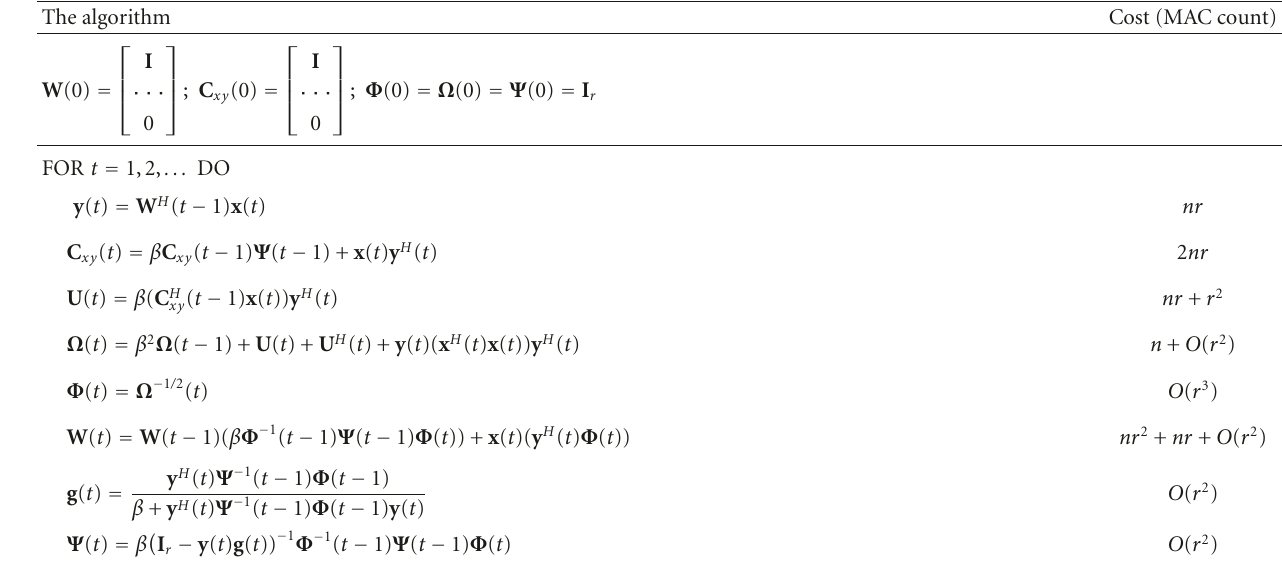
Table 1: Exponential window CPAST algorithm.